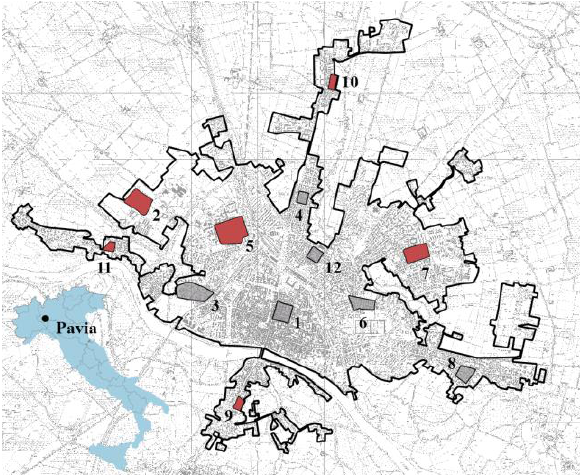
Figure 2. Location of Pavia’s city in Italy; the 12 test area